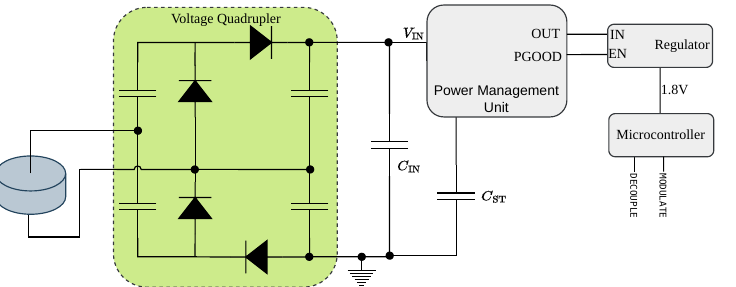
Figure 3. The harvesting circuit connected to the piezoelectric transducer. The voltage quadrupler is adapted from